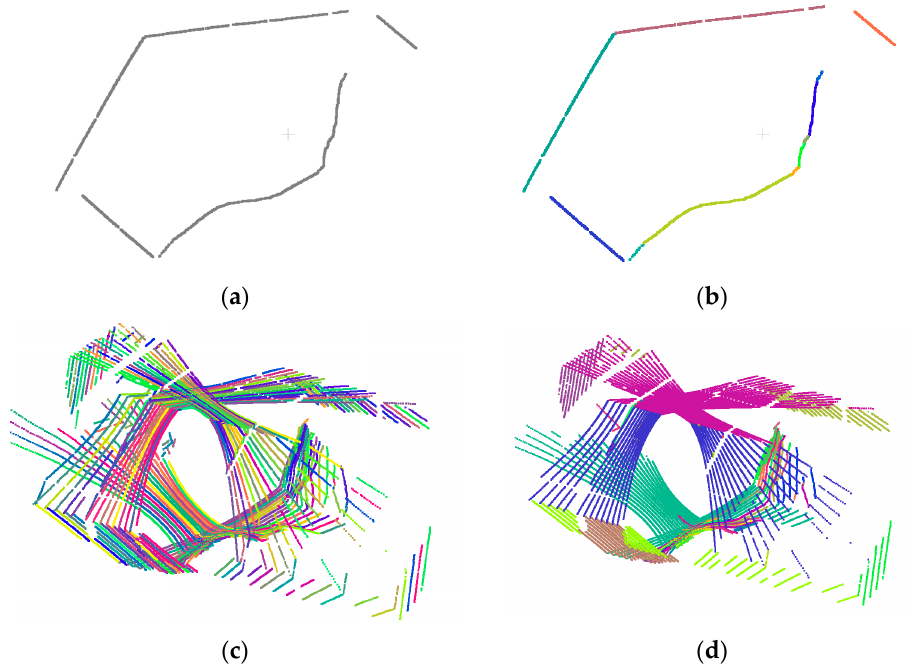
Figure 10. Sample results for the SLS approach: ( a ) point cloud from a single beam scan, ( b ) smooth curve segments along the same point cloud (different curve segments are in different colors), ( c ) derived smooth curve segments from all laser beams in a LiDAR scan (different curve segments are in different colors), and ( d ) planar feature segmentation results (different planar features are in different colors).